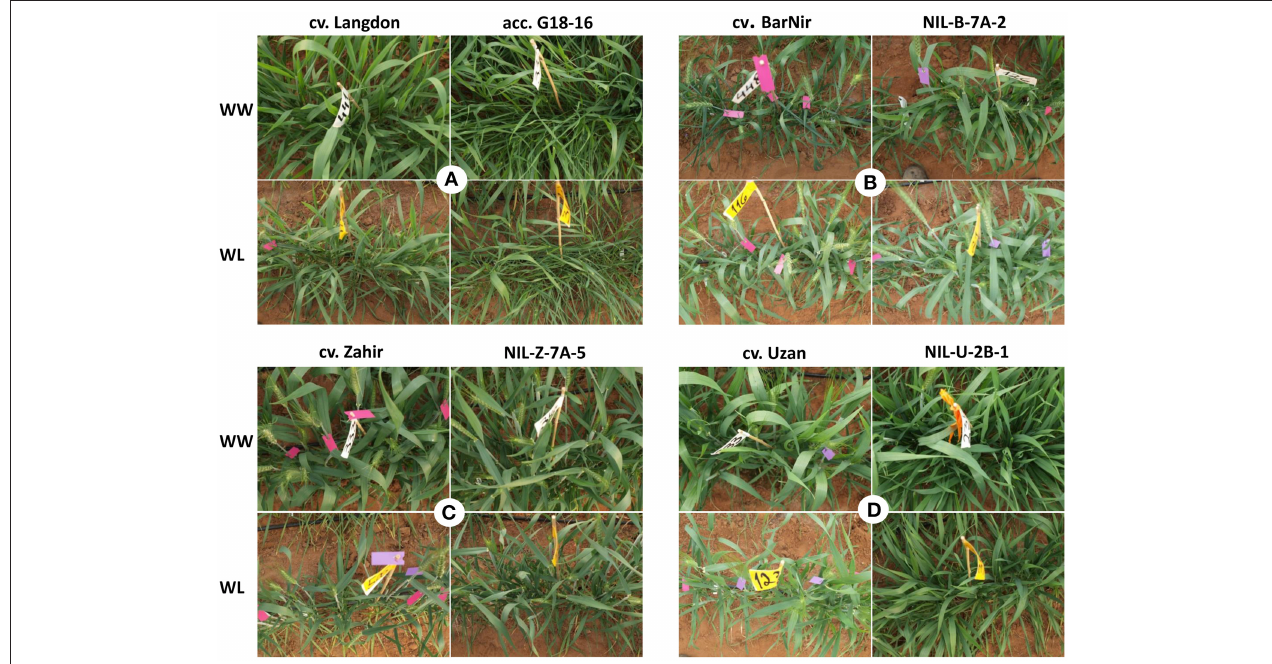
FIGURE 2 | Photographs of typical experimental plots of mapping population parental lines (A), recurrent parents and their derivative NILs (B–D) in Year 1 under the well-watered (WW) and water limited (WL)